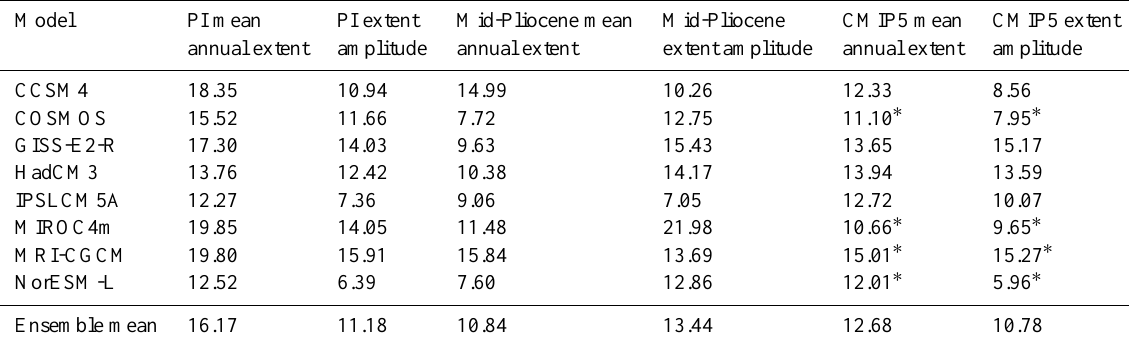
Figure 1. Mean sea ice concentrations (%) for winter (FMA, upper half) and summer (ASO, lower half) in the pre-industrial control simulations for each PlioMIP Experiment 2 model. Missing data at the poles is a plotting artefact (seen also in Figs. 1, 3, 5, and 7). Table 2. Mean annual sea ice extents and amplitudes of sea ice extent (maximum annual sea ice extent minus minimum annual sea ice extent) for the pre-industrial (PI) and mid-Pliocene simulations from PlioMIP, and historical (1979–2005) simulations from CMIP5, for each participant model in PlioMIP Experiment 2 and for the ensemble mean. All values are in 10 6 km 2 . Starred CMIP5 values are from a different version of the model than used in PlioMIP (see Sect. 2.1 for